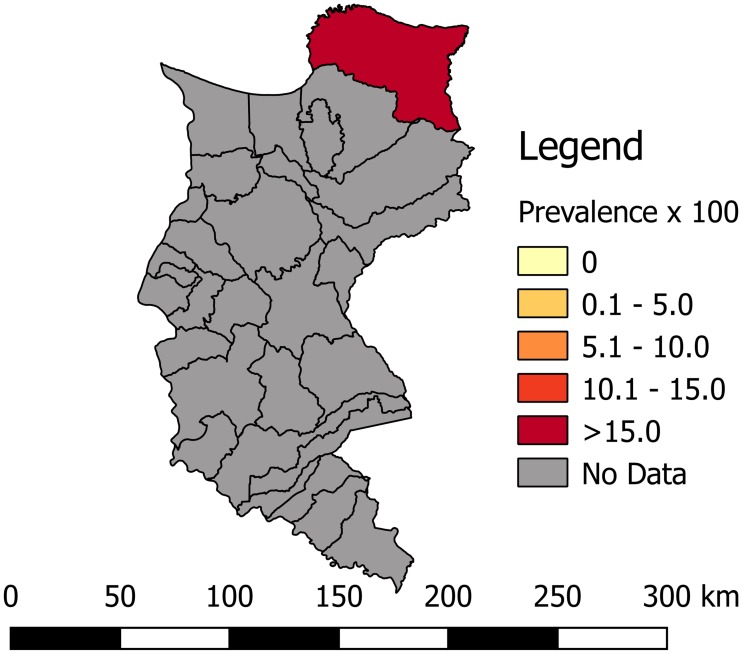
Map of the municipalities of Magdalena showing the distribution of observed Chagas disease prevalence in studies published from 2007 to November 2017.